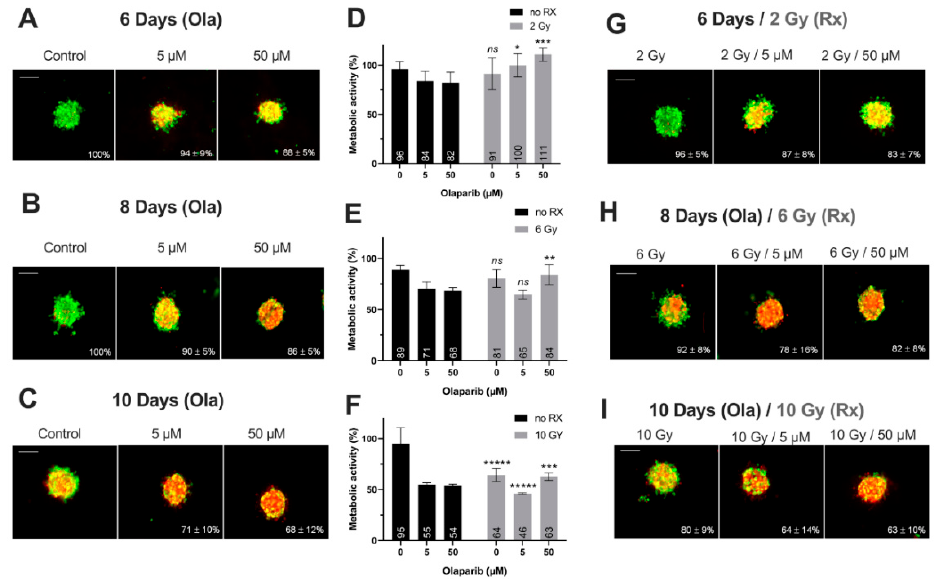
Figure 5. SUM1315 spheroids live / dead profile ( A – C,G – I ) and metabolic activity ( D – F ) after a treatment with Olaparib (“Ola”, 5 and 5 µ M) for 6, 8 and 10 days with or without fractioned irradiation (“Rx”). ( A – C,G – I ) Spheroid viability / mortality profile and spheroid normalized size after a treatment with Olaparib and / or fractioned irradiation for 6 days ( A , G ), 8 days ( B , H ) and 10 days ( C , I ): Images were taken with Cytation3MV where green markings correspond to calcein-AM penetration (viable cells) and red markings correspond to ethidium homodimer-1 cell penetration (dead cells). The percentage of spheroid size was normalized by the size of spheroid controls. Scale bar = 200 µ m. ( D – F ) SUM1315 cell metabolic activity in spheroids with resazurin test after 6 ( D ), 8 ( E ) and 10 days of treatment ( F ). Corrected fluorescence intensity of resorufin (ex / em λ 576 / λ 584 nm) was measured after 15 h incubation with 60 µ M resazurin. The fluorescence intensity of treated spheroids ( n > 15) was normalized by the fluorescence intensity of each associated 0.1% DMSO control spheroids. Results are expressed as mean metabolic activity (%) of each treatment conditions with their standard errors. A student t-test was performed for the statistical comparison of all treatment conditions and the p value is represented in the graphs as ns = non-significant, * p < 0.05, ** p < 0.01, *** p < 0.001 and ***** p < 0.00001.